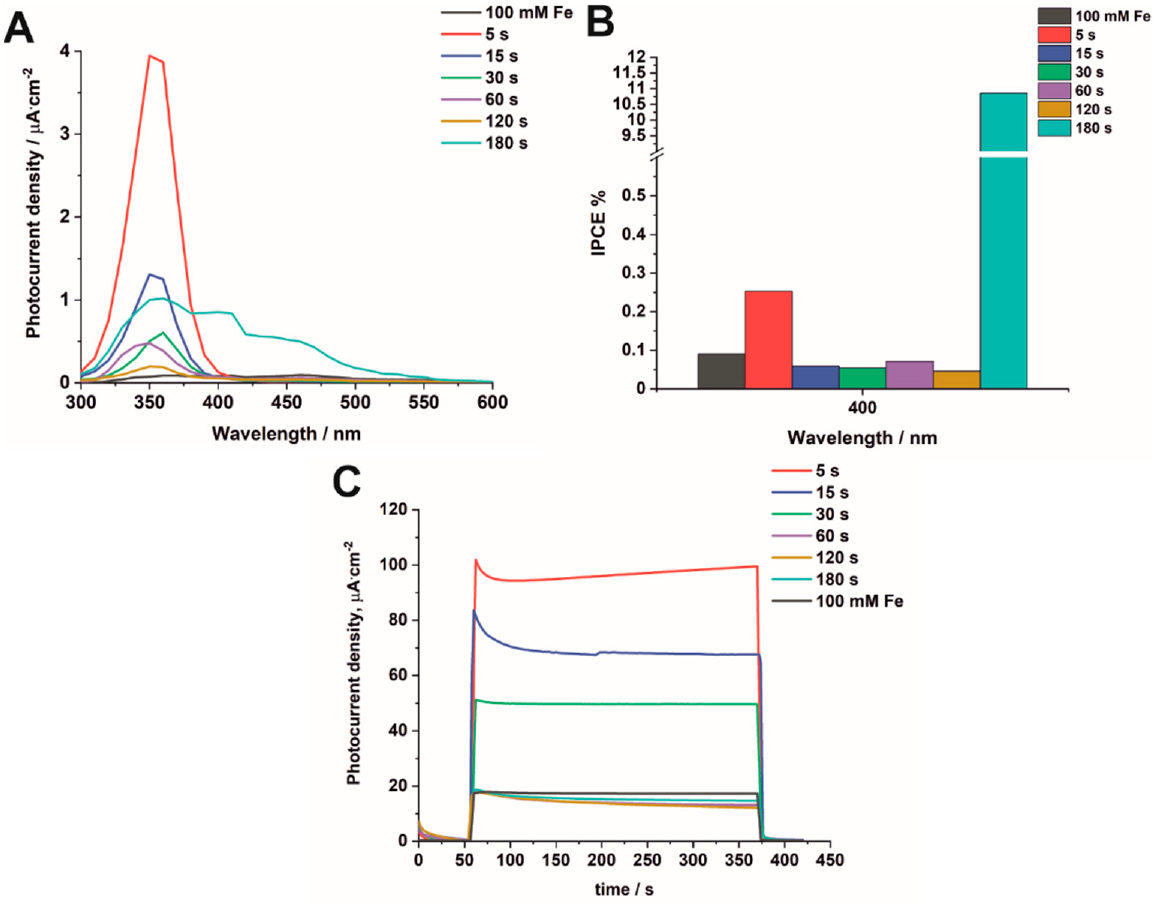
Figure 9. Photocurrent density vs. wavelength curves at 1 V vs. SCE in 0.1 M KNO 3 under monochromatic radiation for Fe 2 O 3 –TiO 2 samples obtained by electrodeposition for 5–180 s and impregnated in 100 mM FeCl 3 ( A ). IPCE values obtained under monochromatic radiation for all modified samples at 400 nm ( B ). Photocurrent density vs. time curves at 1 V vs. SCE in 0.1 M KNO 3 under solar radiation with the Air-Mass 1.5G filter for all modified samples ( C ). The incident photon-to-current efficiency (IPCE) values obtained at 1 V vs. SCE for 400 nm, 450 nm, and 500 nm were calculated as shown in Equation (S2)